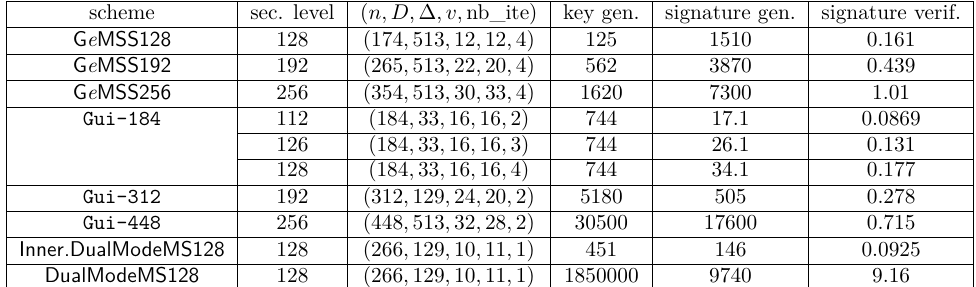
Table 26: Number of mega cycles for each cryptographic operation (best implementation provided for the NIST submissions). We use a Haswell processor (ServerH). Turbo Boost is not